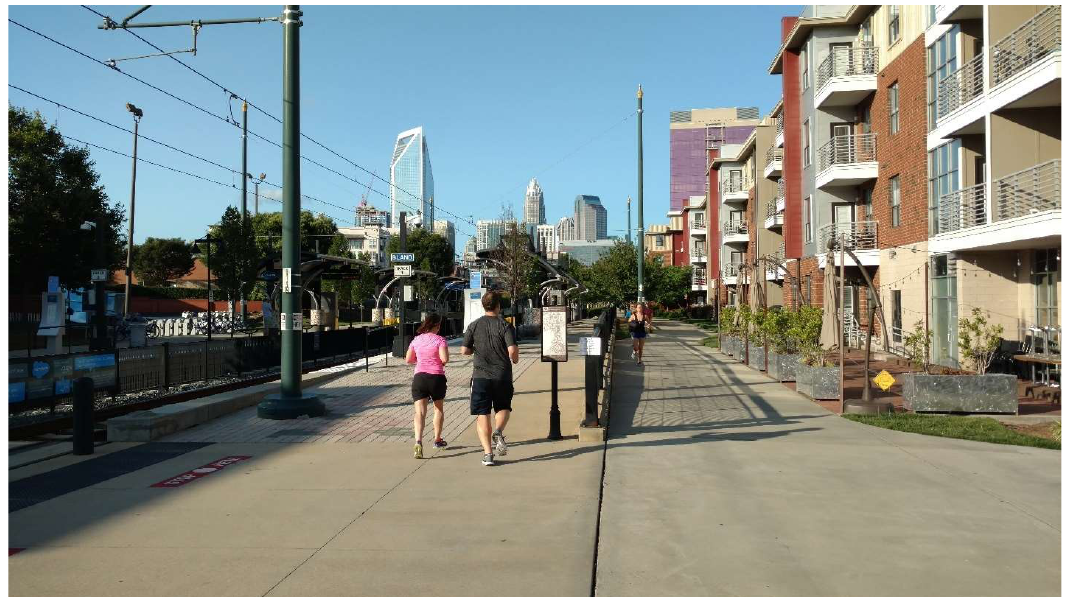
Figure 4. Pedestrian corridor and new up-scale housing along the LYNX light rail line southwest of downtown Charlotte, NC. Photo by author.